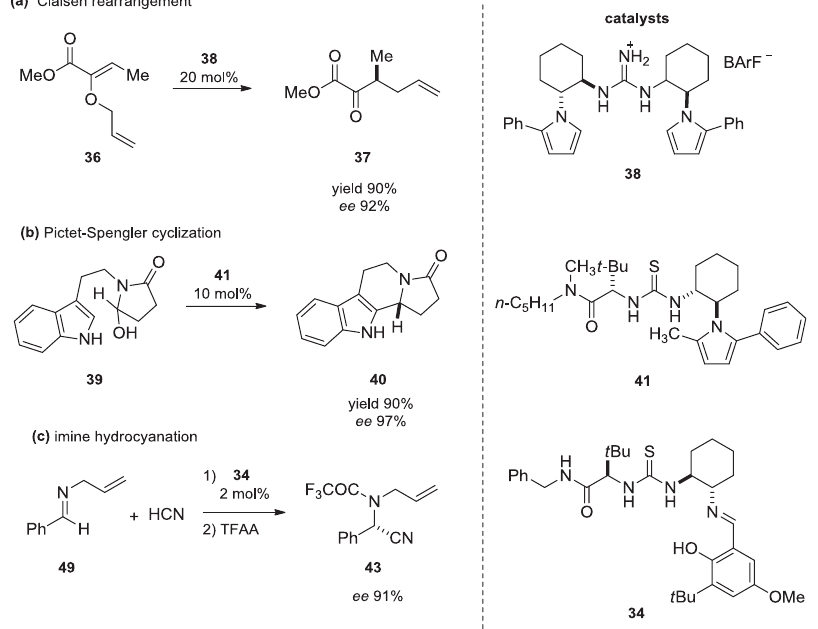
Figure 12. Examples of reactions catalyzed by H-bonding catalysts (38, 41, 34) depicted on the right:: (a) from Ref. [55], (b) from Ref. [56], (c) from Ref.